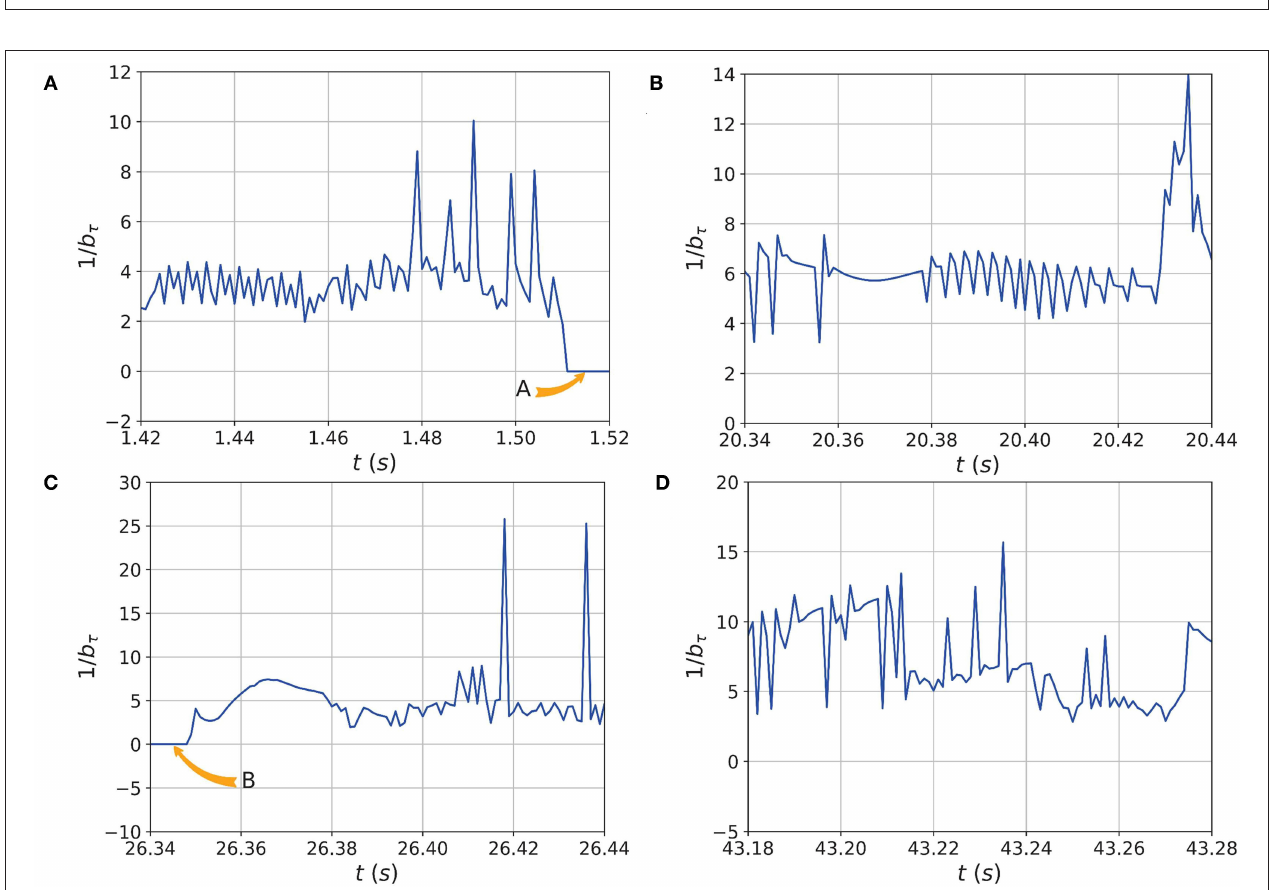
FIGURE 9 | Five different types of stability pyramids with the safety change direction vector in ESPI are represented as T 1, T 2, T 3, T 4, and T 5, respectively. Different combinations of contact points abbreviated as lf , rf , ls , and rs could make different types of stability pyramids with the XCoM as the vertex. Meanwhile, the vectors marked as the red arrow above mean the safety change direction.